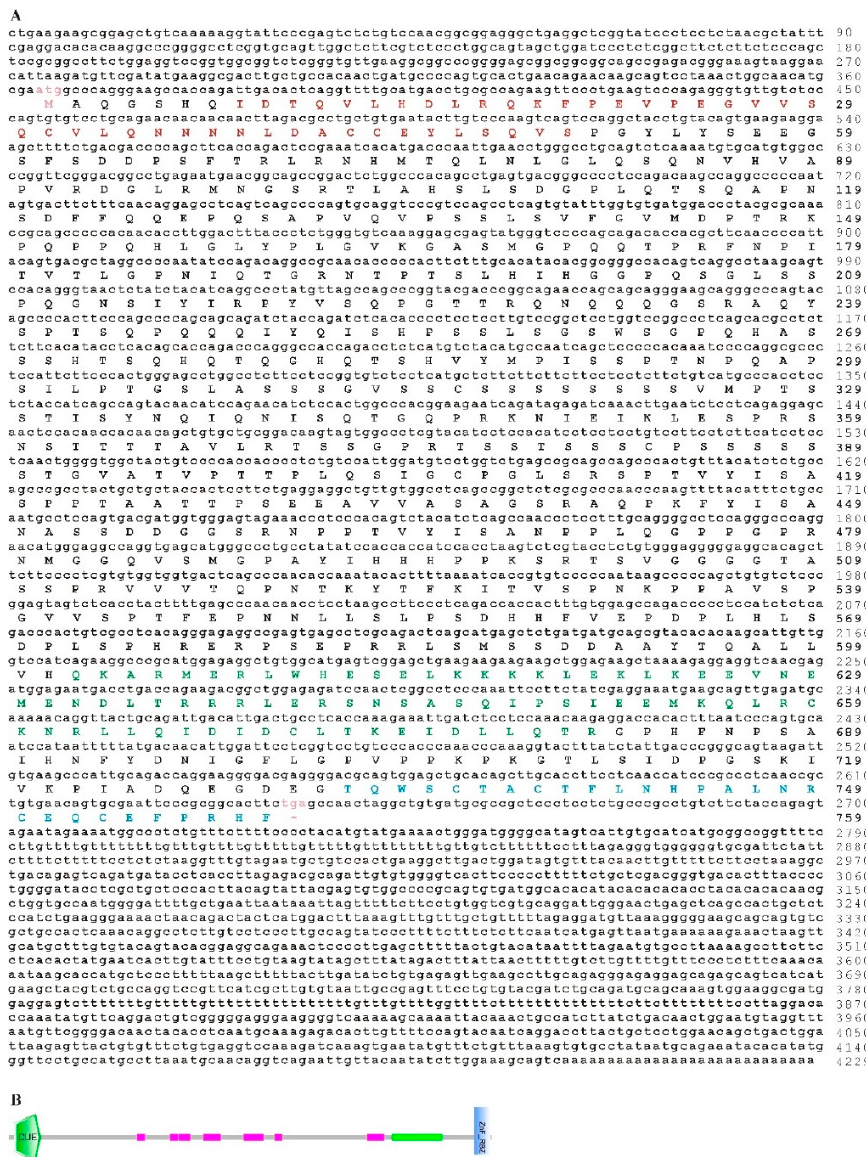
Figure 5. Nucleotide and deduced amino acid sequence of the trTAB2 gene ( A ) and its predicted domains ( B ). The start codon (atg) and stop codon (tga) are marked in pink. The CCR domain is marked in green, the ZnF domain is marked in cyan and the CUE domain is marked in